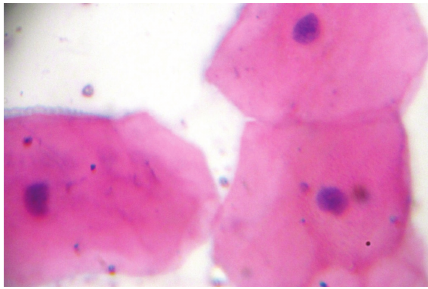
Figure 5: Photomicrograph showing epithelial cells with normal cellular and nuclear morphology